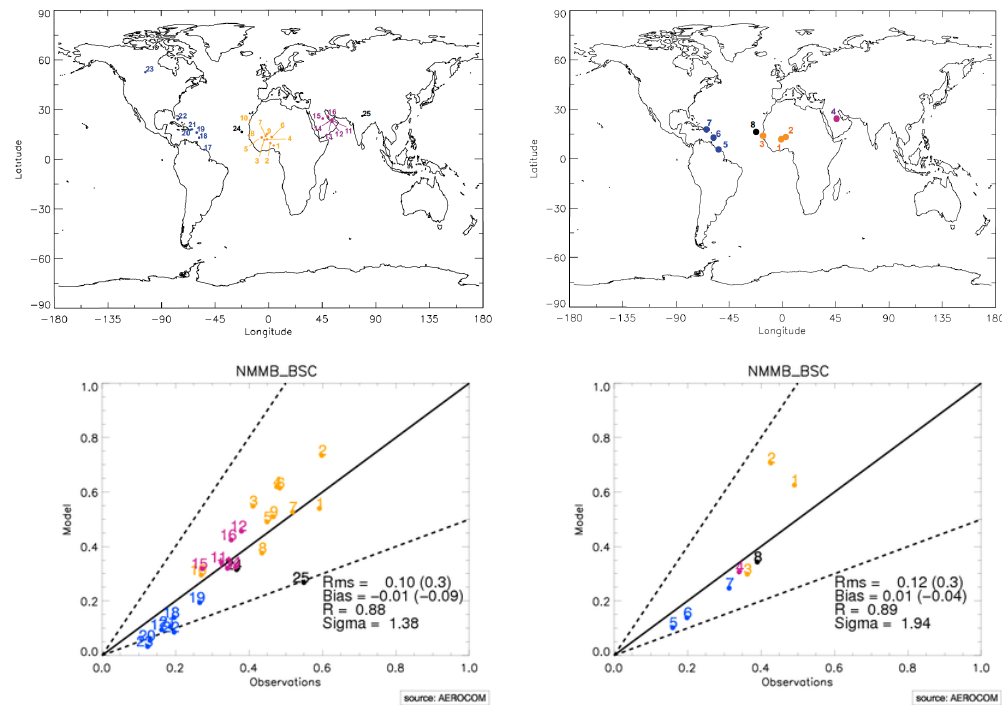
Fig. 12. Upper panels show the location of selected AERONET dusty sites based on the climatology build from the multi-annual database 1996–2006 (left) and for year 2000 (right). Names and locations for each selected station are given in ( Huneeus et al., 2011). Bottom panels show the averaged AOD at 550nm versus modeled one for the climatology (left) and for year 2000 (right). Root mean square error (RMS), bias, ratio of modeled and observed standard deviation ( σ ) and correlation ( R ) are indicated in the scatter plot. Normalized mean bias and normalized root mean square error are given in parenthesis next to RMS and mean bias, respectively. Black continues line is the 1:1 line whereas the black dotted lines correspond to the 2:1 and 1:2 lines. 61